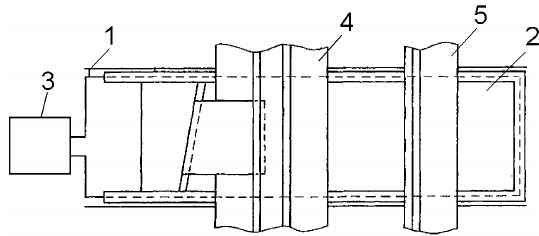
Figure 9. Snow melting system on switch points: 1: winding, 2: substrate plate, 3: power supply and control system, 4: stock-rail, and 5: switch-rail [15].